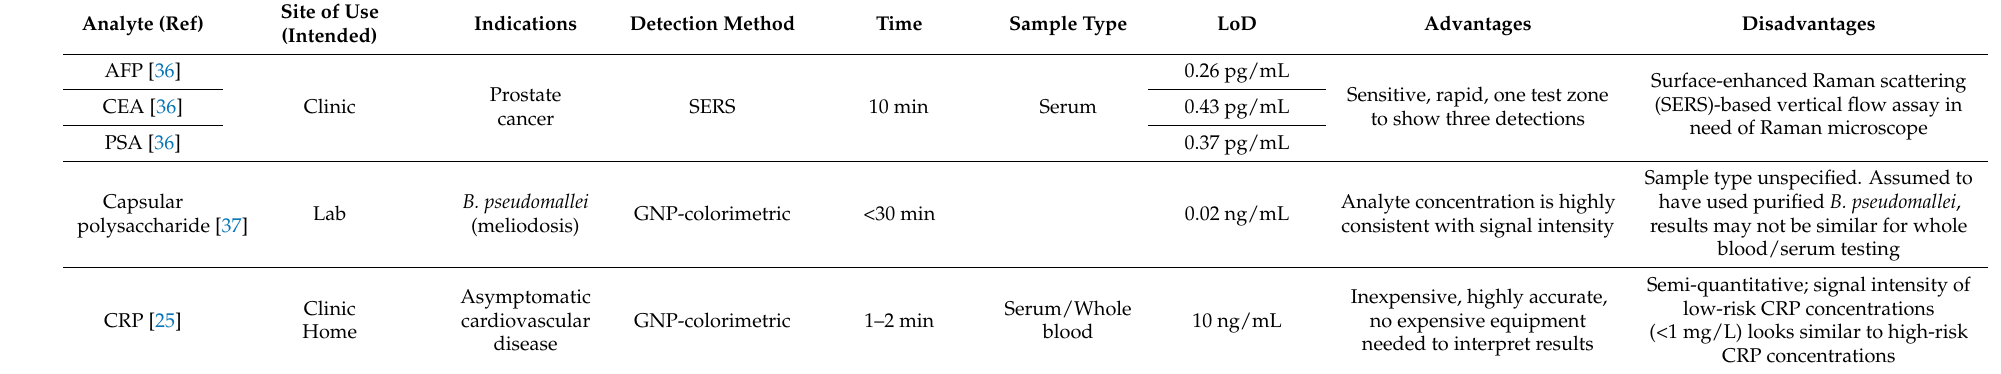
Table 3. Vertical flow assays for protein